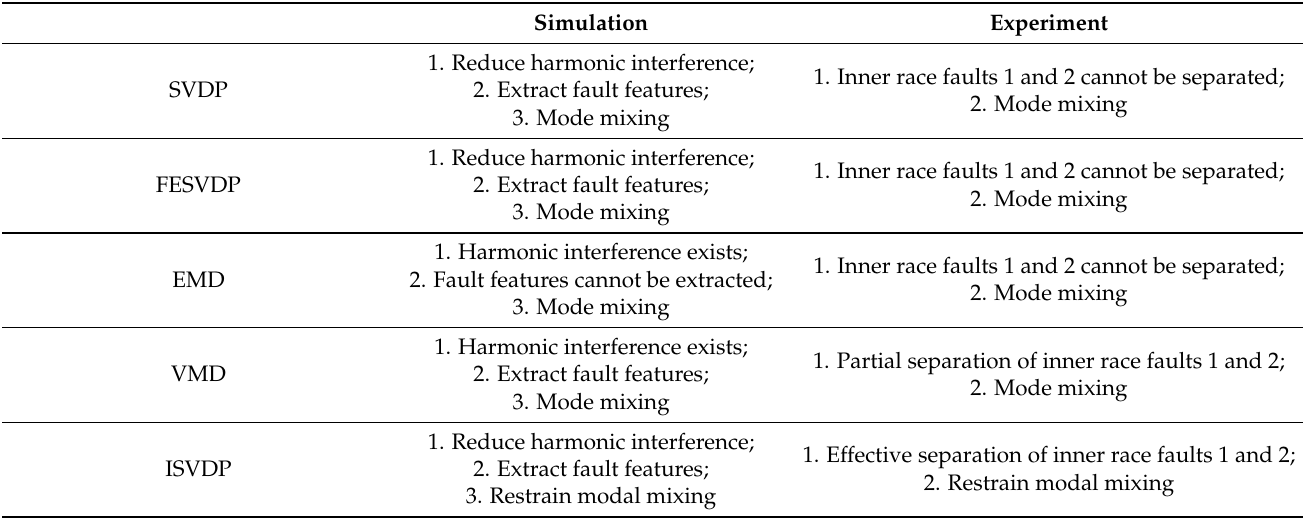
Table 3. Comparison of the results of five algorithms in simulations and